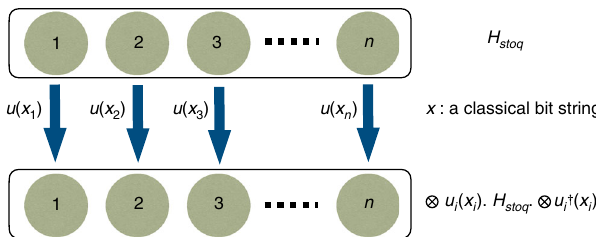
Fig. 1 A classical bit string connecting a stoquastic Hamiltonian to a seemingly non-stoquastic Hamiltonian. One may generate an n -qubit stoquastic Hamiltonian H stoq and then transform it using a randomly chosen unitary (speci fi ed by a classical bit string) to bring it into a seemingly non- stoquastic form. Unlike the generated stoquastic Hamiltonian, the simulation of the seemingly non-stoquastic Hamiltonian can be computationally hard. Also, as discussed here, given a non-stoquastic Hamiltonian, fi nding the bit string that converts it into a stoquastic Hamiltonian can be computationally hard in general. Therefore, the classical bit string can serve as a secret key, without which certain properties of H